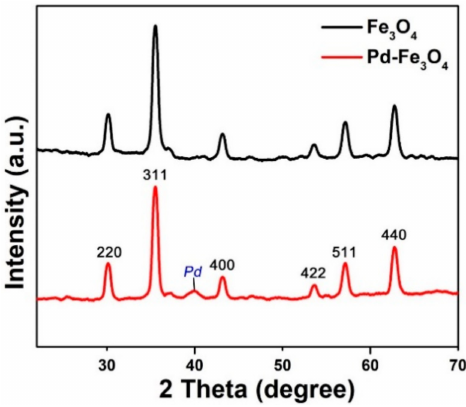
Figure 1. XRD patterns of Fe 3 O 4 and Pd-Fe 3 O 4.